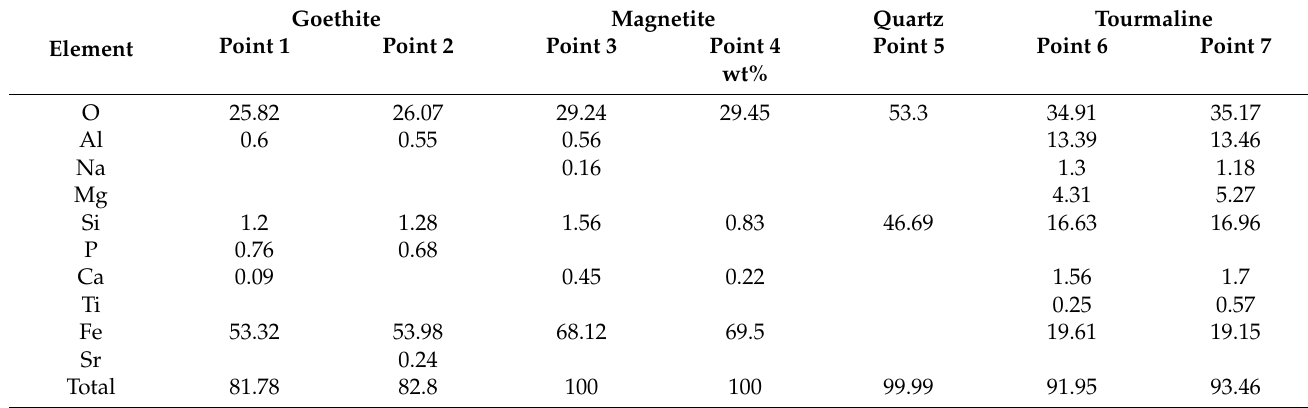
Table 1. Concentration of major elements